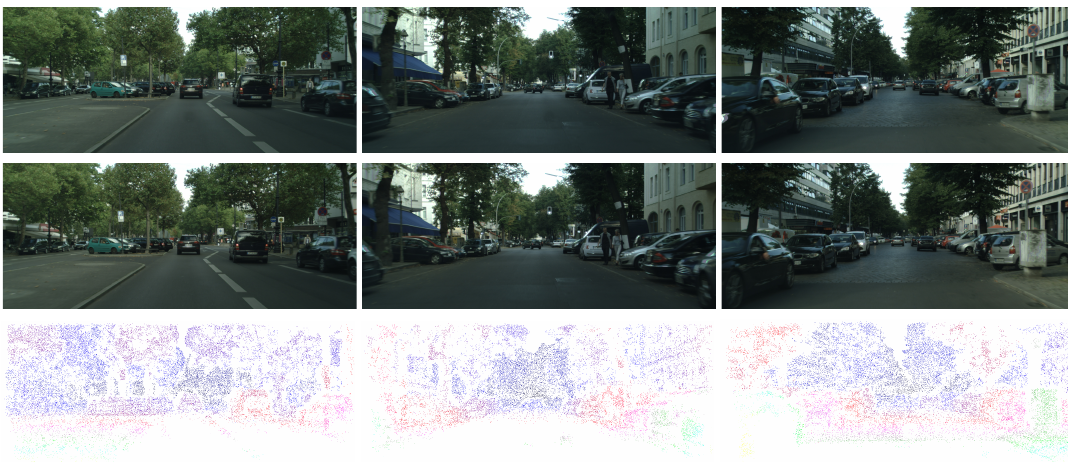
Figure 5. Examples of our ground truth. From top to bottom: the left images, the right images, and our ground